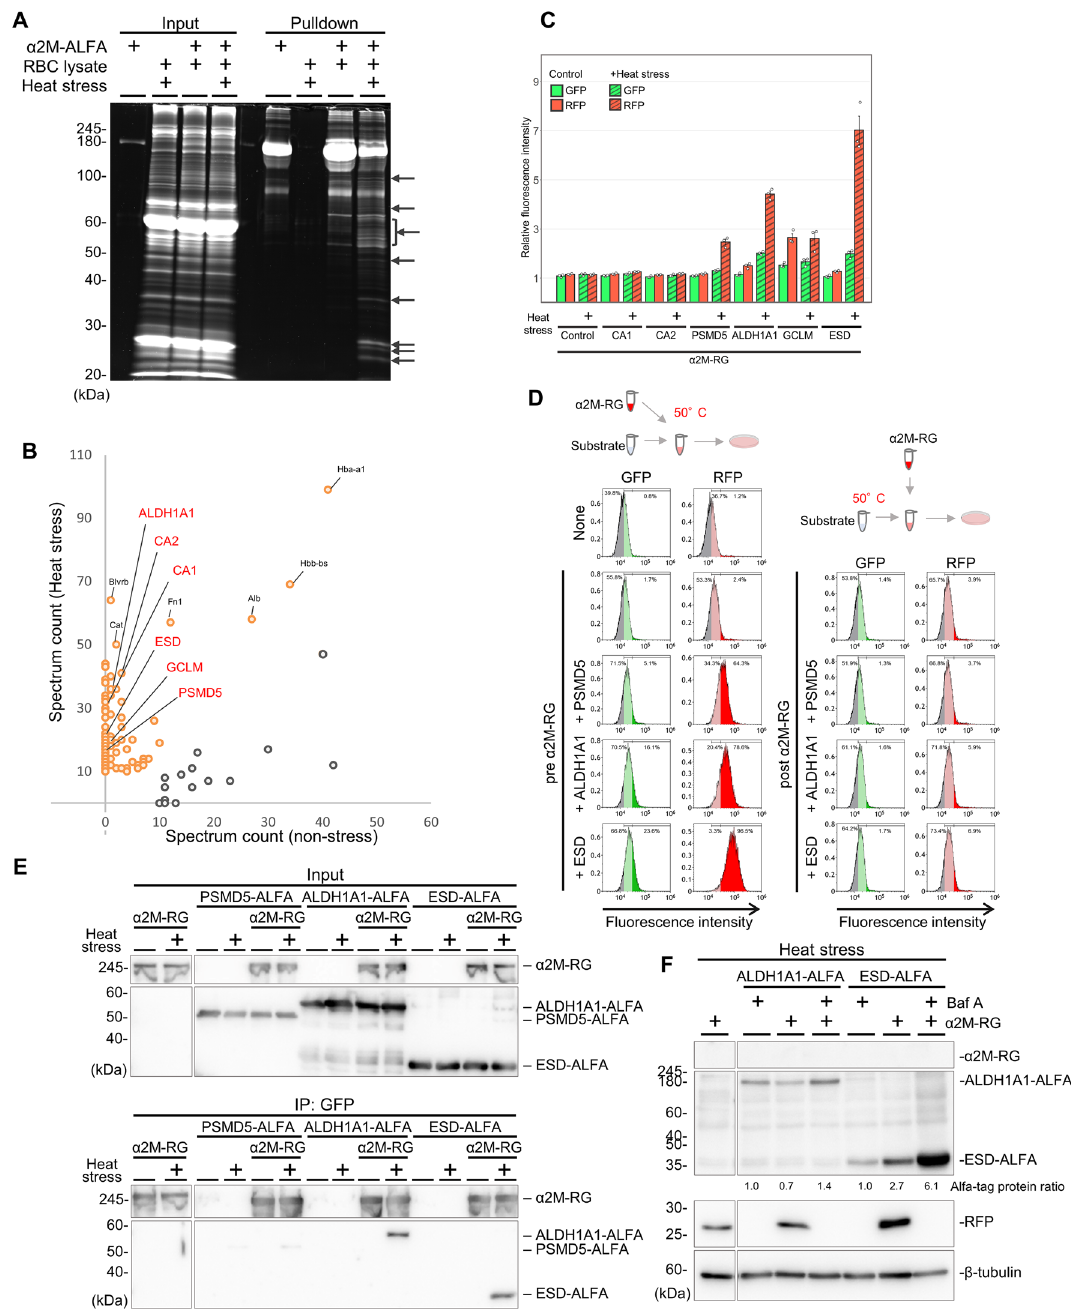
Figure 2. Identification of misfolding-dependent substrates for α 2 M. ( A ) Several heat-stressed proteins directly interacted with α 2 M. Purified α 2 M–ALFA was mixed with or without RBC lysate, then pre-incubated at 4 °C or 50 °C (heat stress) for 1 h. Samples were subjected to co-immunoprecipitation with anti-ALFA sepharose and analyzed by ruby staining. ( B ) Mass spectrometric analysis of α 2 M-binding proteins (see also Table S1). Orange (gray) dots indicate proteins that bind α 2 M in a heat stress-dependent (independent) manner. ( C ) α 2 M–RG internalization assay with substrates. Six substrates (CA1, CA2, PSMD5, ALDH1A1, GCLM, and ESD) and α 2 M–RG were heat-shocked in serum-free medium at 50 °C for 1 h. HeLa cells were cultured in medium for 17 h at 37 °C, then analyzed using flow cytometry. Bar graph shows the relative fluorescence intensities of GFP and RFP in cells normalized to those intensities in untreated cells (n = 3). Data are means ± SEMs. Small circles indicate each data point. ( D ) α 2 M did not deliver aggregated proteins to lysosomes. Substrates (PSMD5, ALDH1A1, or ESD) were co-heated with α 2 M–RG at 50 °C (left panel) or pre-heated alone, then mixed with α 2 M–RG (right panel). HeLa cells were cultured in medium for 17 h at 37 °C, then analyzed using flow cytometry (n = 1). ( E ) α 2 M interacted directly with substrates. PSMD5, ALDH1A1, and ESD were each mixed with or without α 2 M–RG, then pre- incubated at 4° or 50 °C (heat stress) for 1 h. Samples were subjected to co-immunoprecipitation with anti-GFP sepharose. ( F ) α 2 M– RG cleavage assay with ALDH1A1 and ESD. Huh7 cells were treated as described in ( C ), and the cells were lysed for immunoblotting using anti-GFP, anti-ALFA RFP, and anti-β-tubulin. Quantitative analysis of band intensity using ImageJ. Data are presented as the ratio of Alfa-tag protein (α 2 M–RG or α 2 M–RG + Baf A treated sample/Baf A treated sample) after normalization to tubulin as mean of two independent